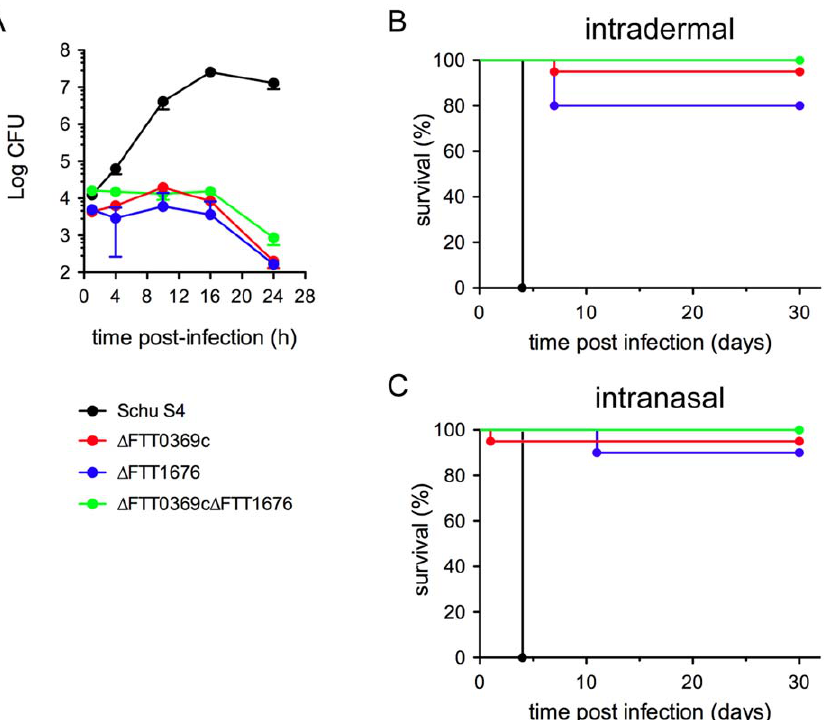
Figure 1. Invitro and invivo attenuation of SchuS4 D FTT0369c, D FTT1676 and D FTT0369c D FTT1676 mutants. ( A ) Intracellular growth of F. tularensis SchuS4, D FTT0369c, D FTT1676 and D FTT0369c D FTT1676 strains in murine BMMs derived from C57Bl/6J mice. BMMs were infected with either strains, as described in the Materials and Methods section, and intracellular viable bacteria were enumerated at the indicated times points after infection. Values are means 6 SD of a representative experiment performed in triplicate. Data is representative of 2 experiments of similar design. (B– C) Balb/c mice (n=5–10/group) were infected intradermally (B) or intranasally (C) with approximately 50 CFU or 10 CFU, respectively, of the indicated strains of F. tularensis SchuS4. Mice were regularly monitored up to 30 days after infection and euthanized at the first sign of irreversible